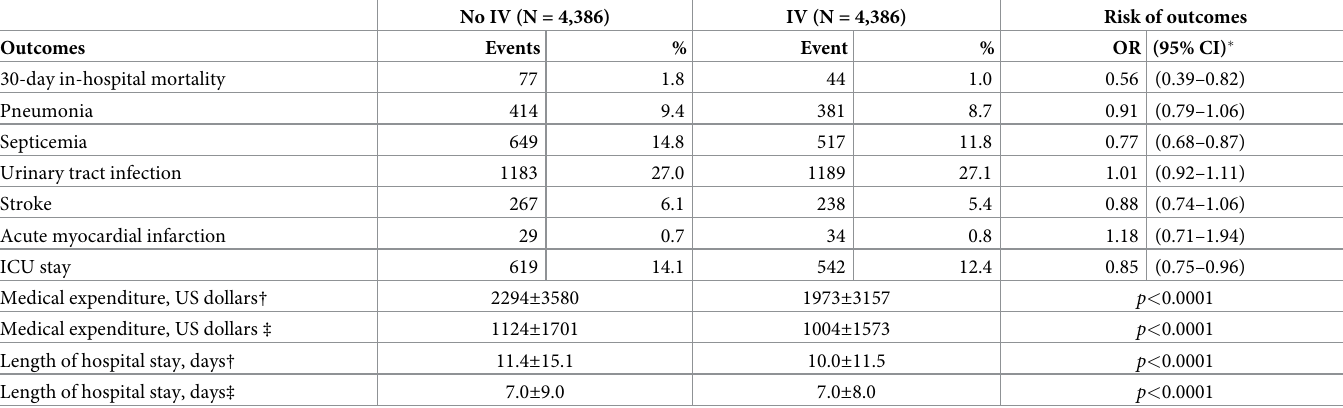
Table 3. Adverse outcomes of kidney disease admissions for patients with and without influenza vaccination (after propensity-score